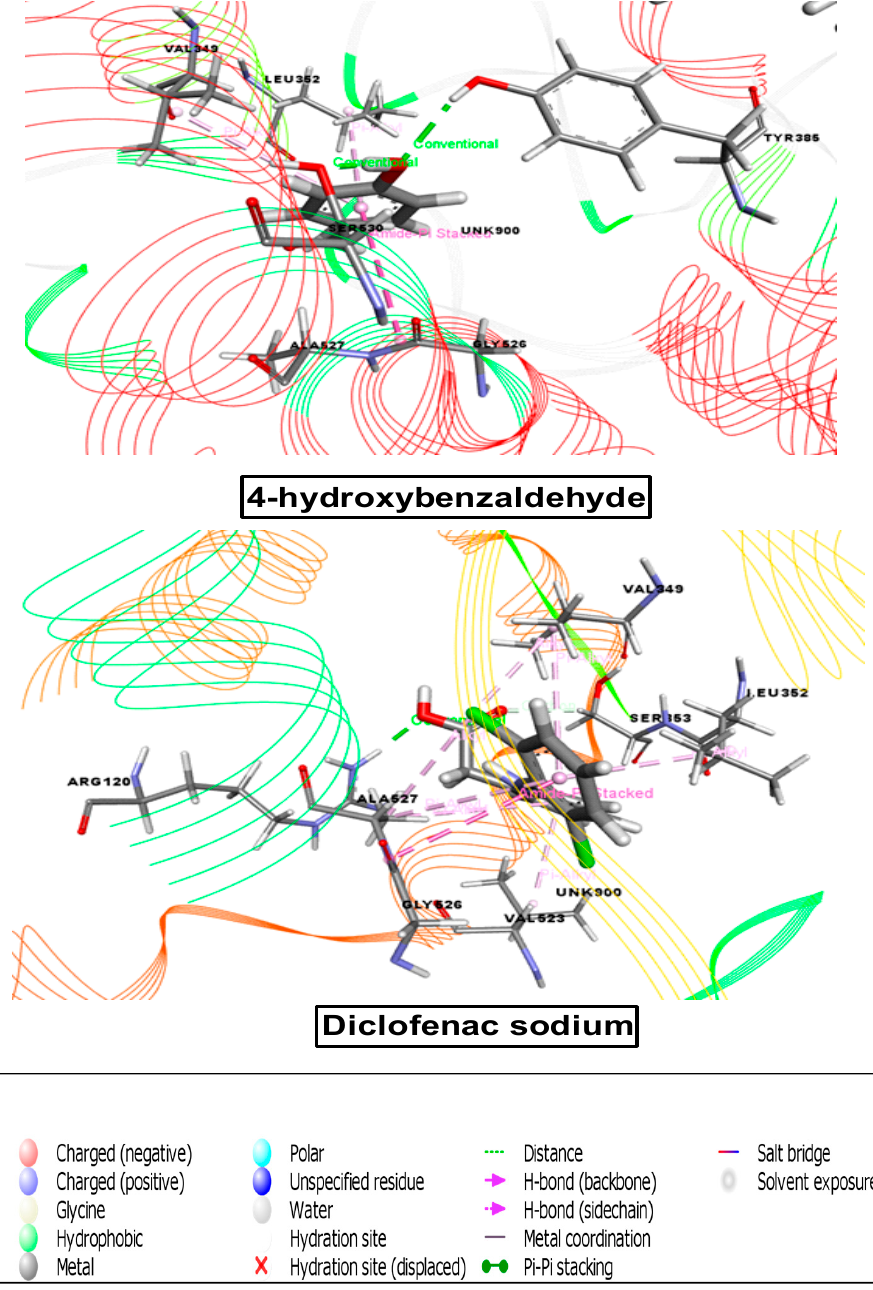
Figure 8. Best ranked pose of the major compounds of M. capitulata. 4-hydroxybenzaldehyde and standard drug (diclofenac sodium) in the binding pocket of COX-2 enzyme (PDB ID: 6COX) for analgesic and anti-inflammatory activities.